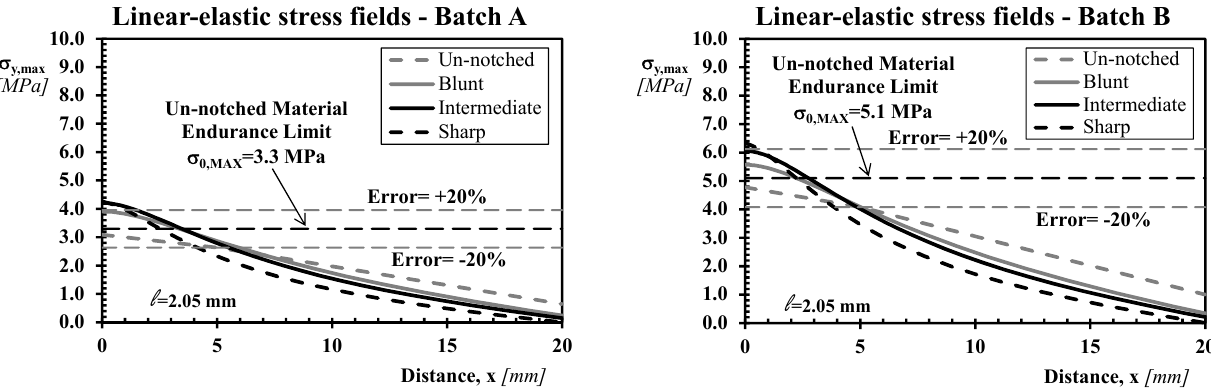
Figure 4: Accuracy of GE applied by taking l = 2.05 mm, Eq. (6) .